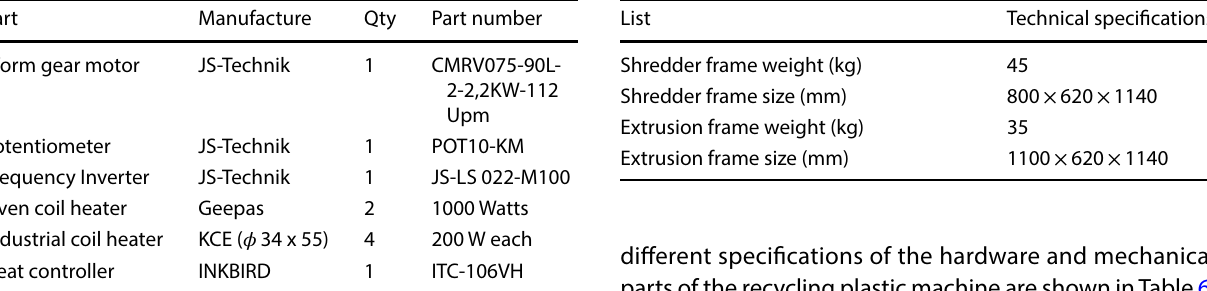
(a) Assembly of the extruder. (b) Fitting the extruder into a